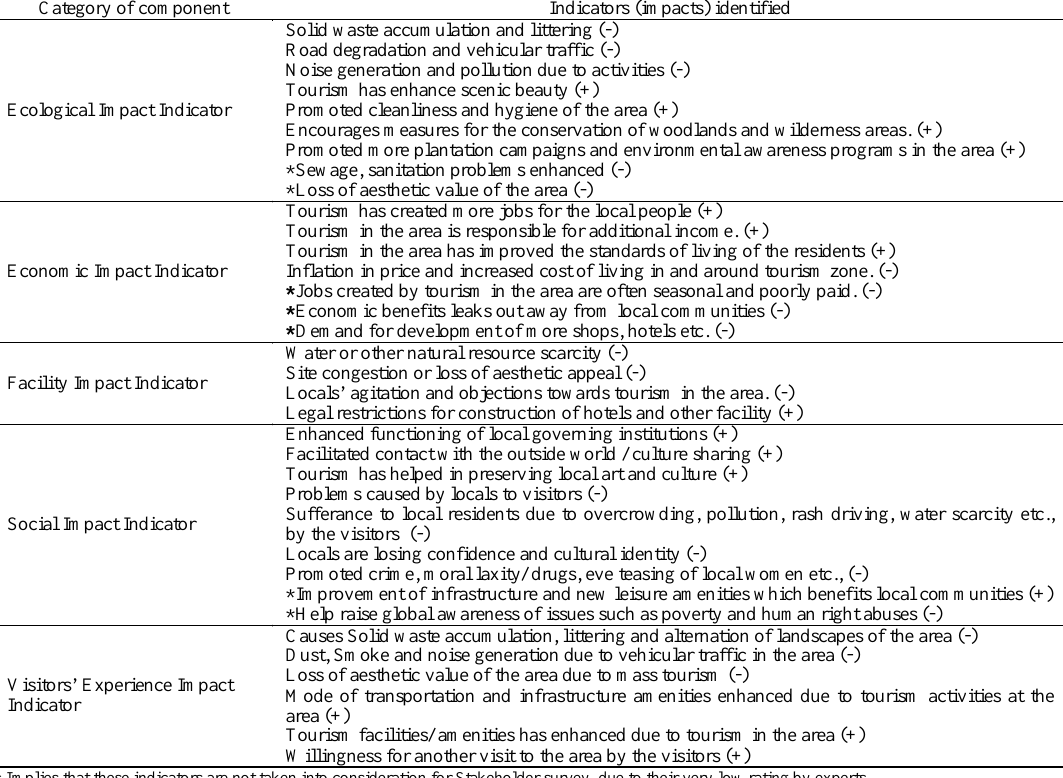
Table 2: List of indicators and component categories identified by Delphi survey for Kerwa catchment area, Bhopal Category of component